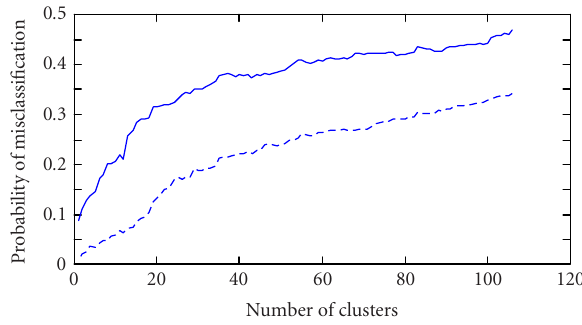
Figure 6: Probability of misclassification verses the number of clus- ters when an unknown utterance was mapped to the nearest cluster (solid) and two nearest clusters (dashed). tion versus the number of voiced frames used in training